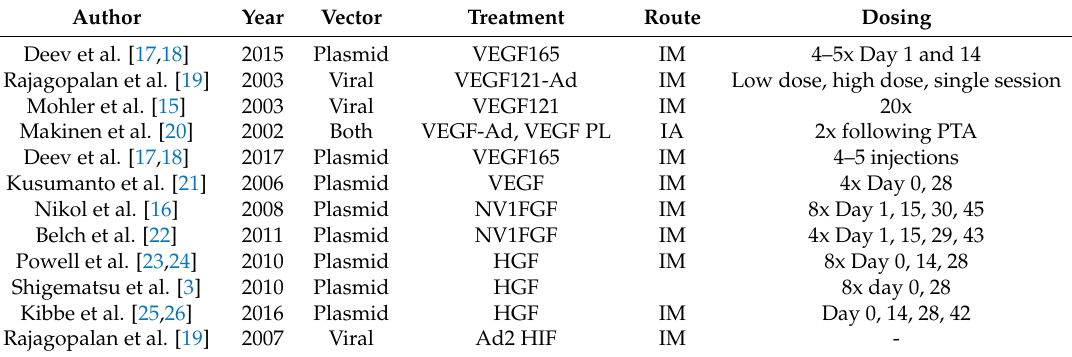
Table 1. Summary of recent vascular endothelial growth factors (VEGF) and angiogenic vector- based